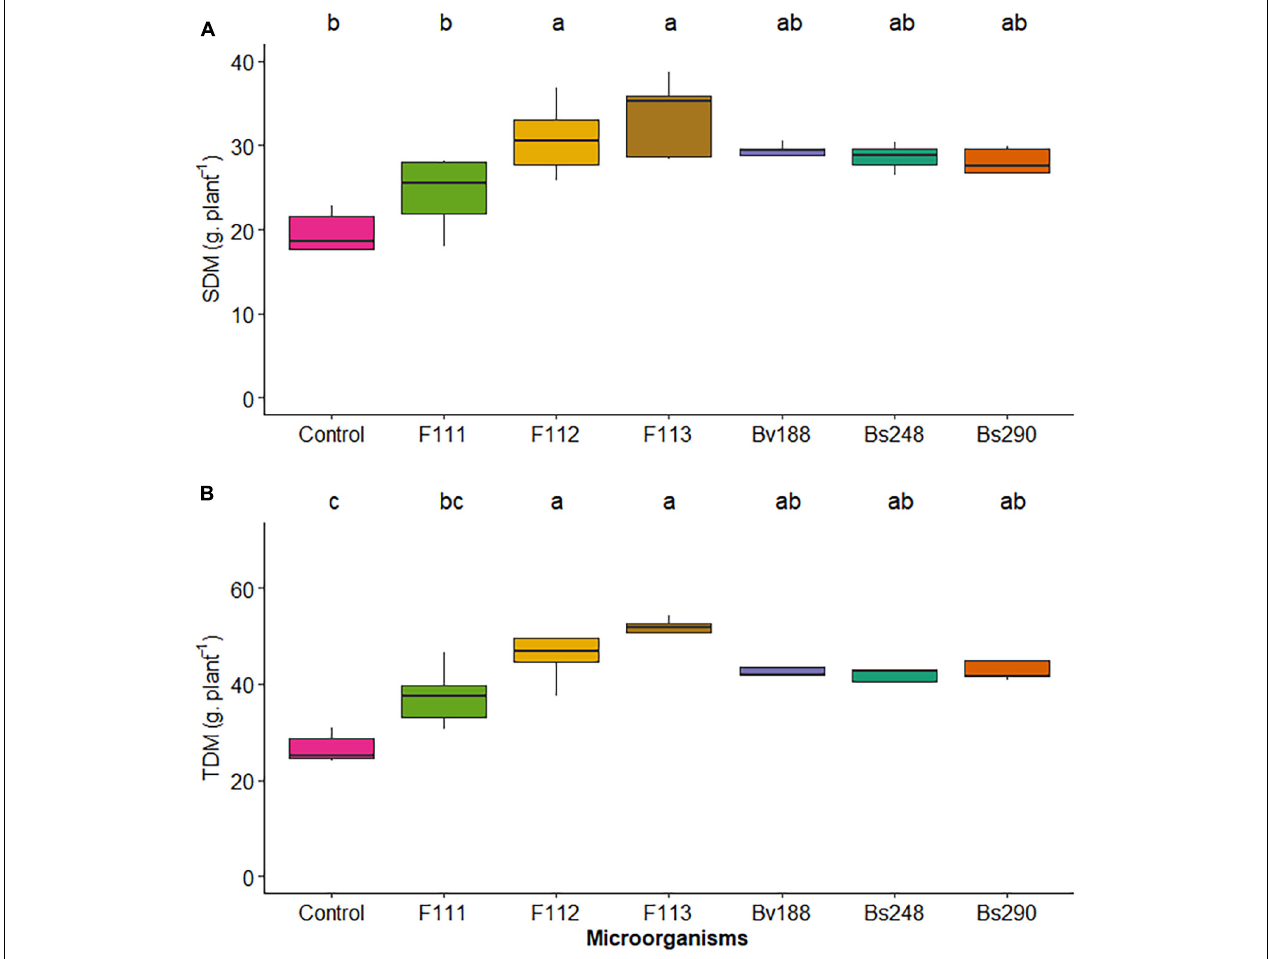
FIGURE 1 | Boxplots (median and quartiles) of SDM (A) and TDM (B) in cotton inoculated with plant growth-promoting microorganisms. Different lowercase letters in the line indicate statistical difference between means (Tukey, p < 0.05). F111, Aspergillus brasiliensis ; F112, Aspergillus sydowii ; F113, Aspergillus sp.; Bv188, Bacillus velezensis strain Bv188; Bs248, Bacillus subtilis strain Bs248; Bs290, B. subtilis strain Bs290; Ctrl, control; SDM, shoot dry matter; TDM, total dry